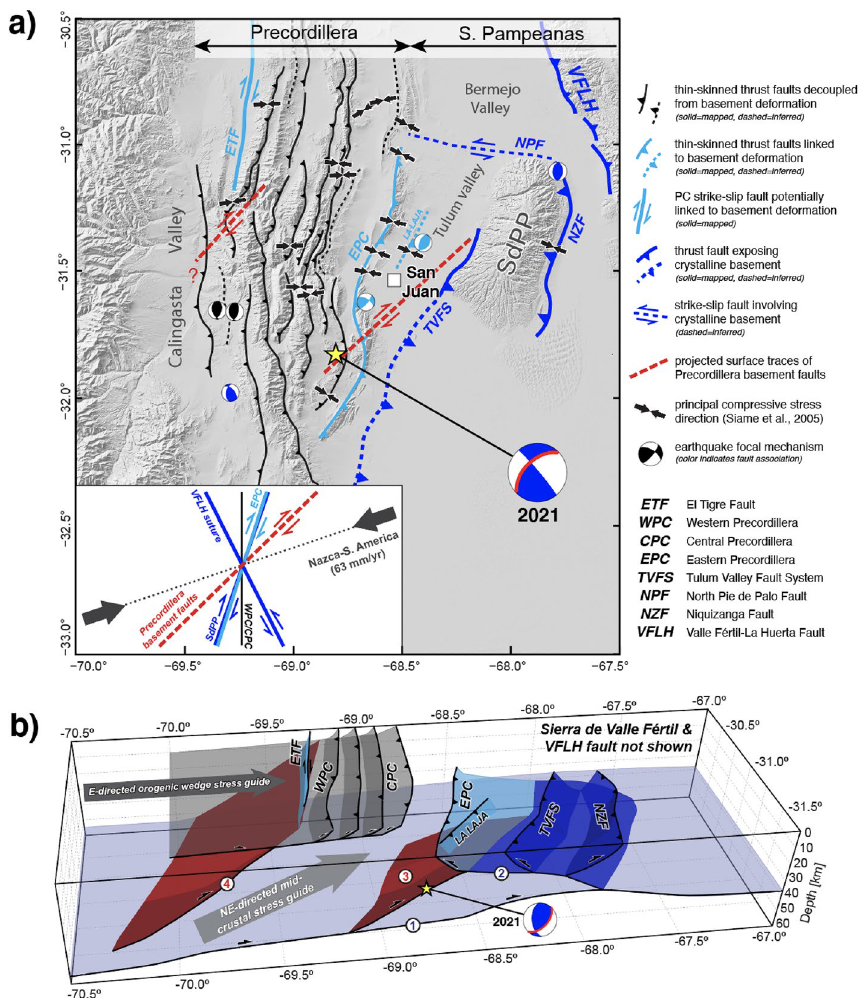
Figure 6. ( a ) Regional map illustrating middle- to upper-crustal interactions and inferred kinematic affiliations among retroarc structures. Red dashed lines show projected surface intercepts of Precordillera basement faults inferred from microseismicity data 27,32 . Black arrows show direction of principal compressive stress estimated from fault slip data 10 . Bottom inset depicts predicted Neogene-Quaternary partitioning of the N70 convergence vector along variably oriented, middle- to upper-crustal retroarc features (modified from 10,27,30,63 . ( b ) Schematic block diagram showing proposed relationships among NE-striking, probably inherited basement faults and emergent structures in the Precordillera and western Sierras Pampeanas, in a South America fixed reference frame. Fault-like structures inferred from geophysical data are marked with red and blue numbered circles and correspond to structural features described in the text. The Note that the SJ2021 focal mechanism has been rotated into the southern cross section plane. This figure was created with the GMT package (V.6.0.0, https:// www. gener ic- mappi ng- tools. org/. Topographic information in a ) comes from the Shuttle